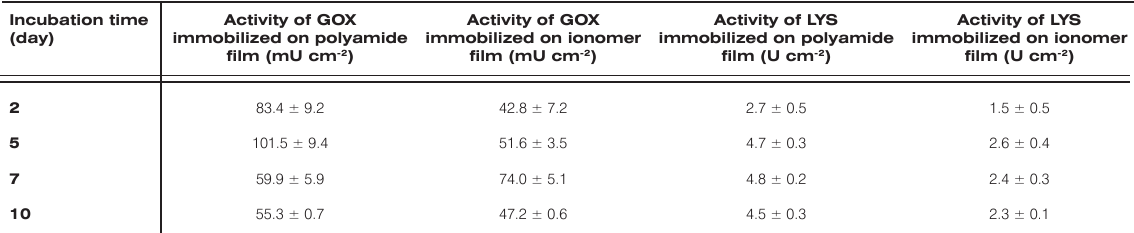
Table 2. Activity of GOX and LYS immobilized on polyamide or ionomer film treated with the amount of 24.8 U cm -2 of GOX and 40000 U cm -2 of LYS after various incubation time.